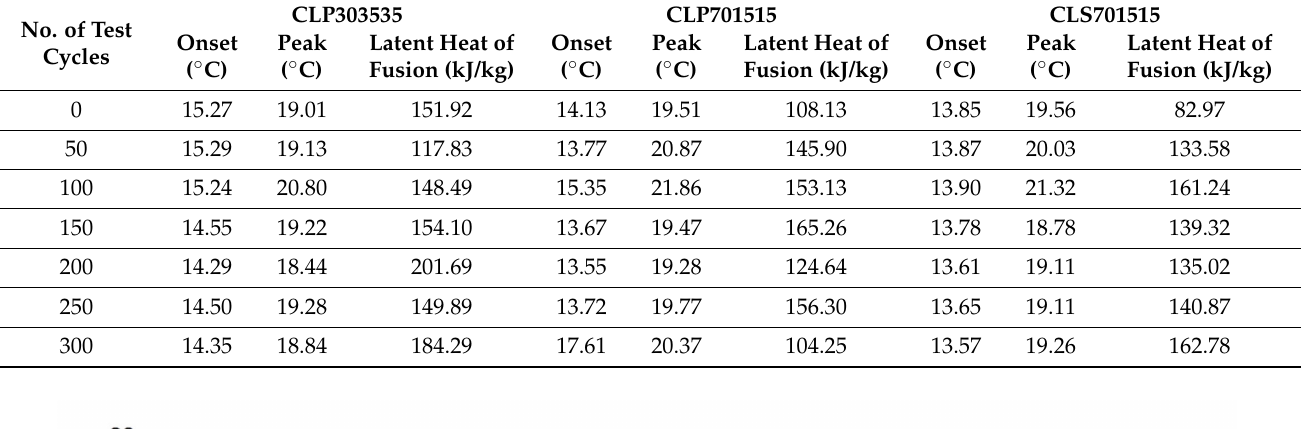
Table 3. Latent heat of fusion and melting temperature of developed materials with test cycles (CLP303535, CLP701515, and CLS701515).